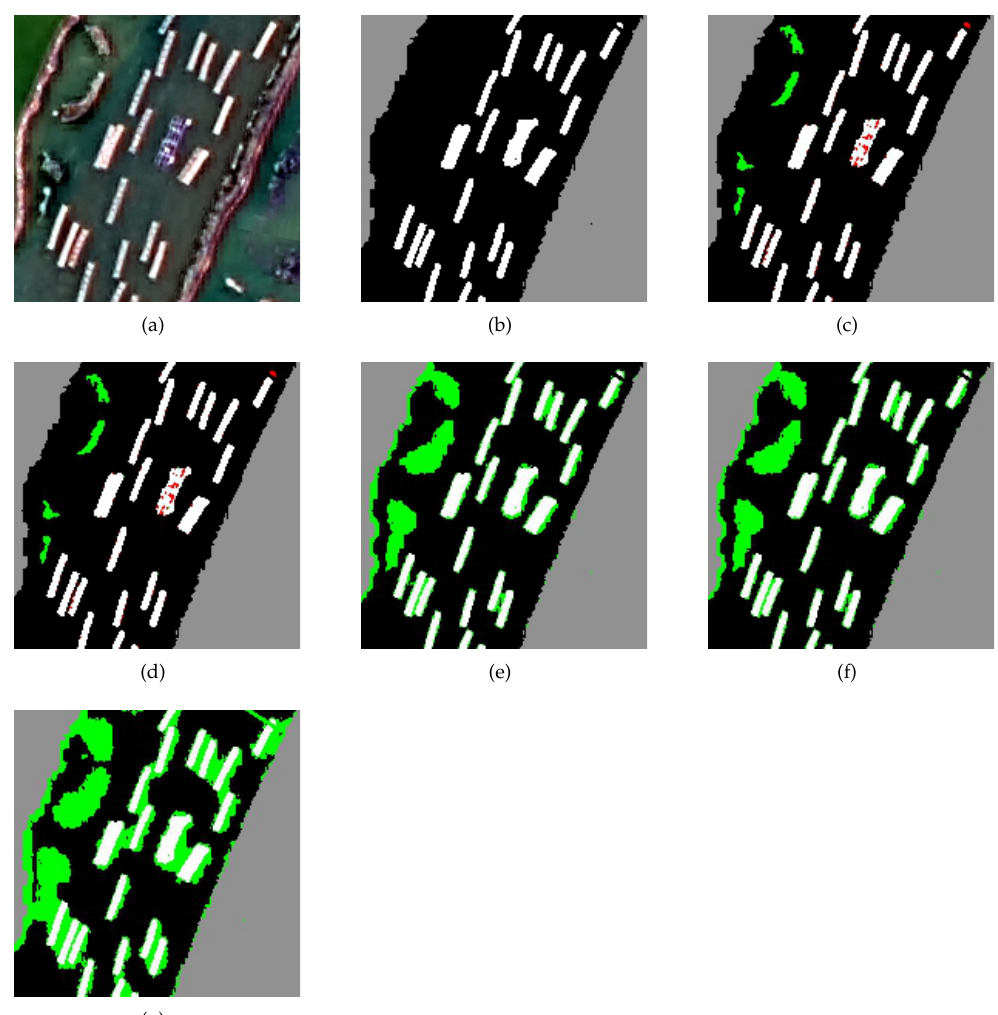
Figure 7. The details of the results of aquatic product extraction by different methods in Region c, with a black color denoting the background, white color denoting the aquaculture raft, red color denoting the missing extraction, and green color denoting more extraction. ( a ) Original image. ( b ) Ground truth image. ( c ) IEGD. ( d ) CEM. ( e ) NN. ( f ) SVM. ( g )